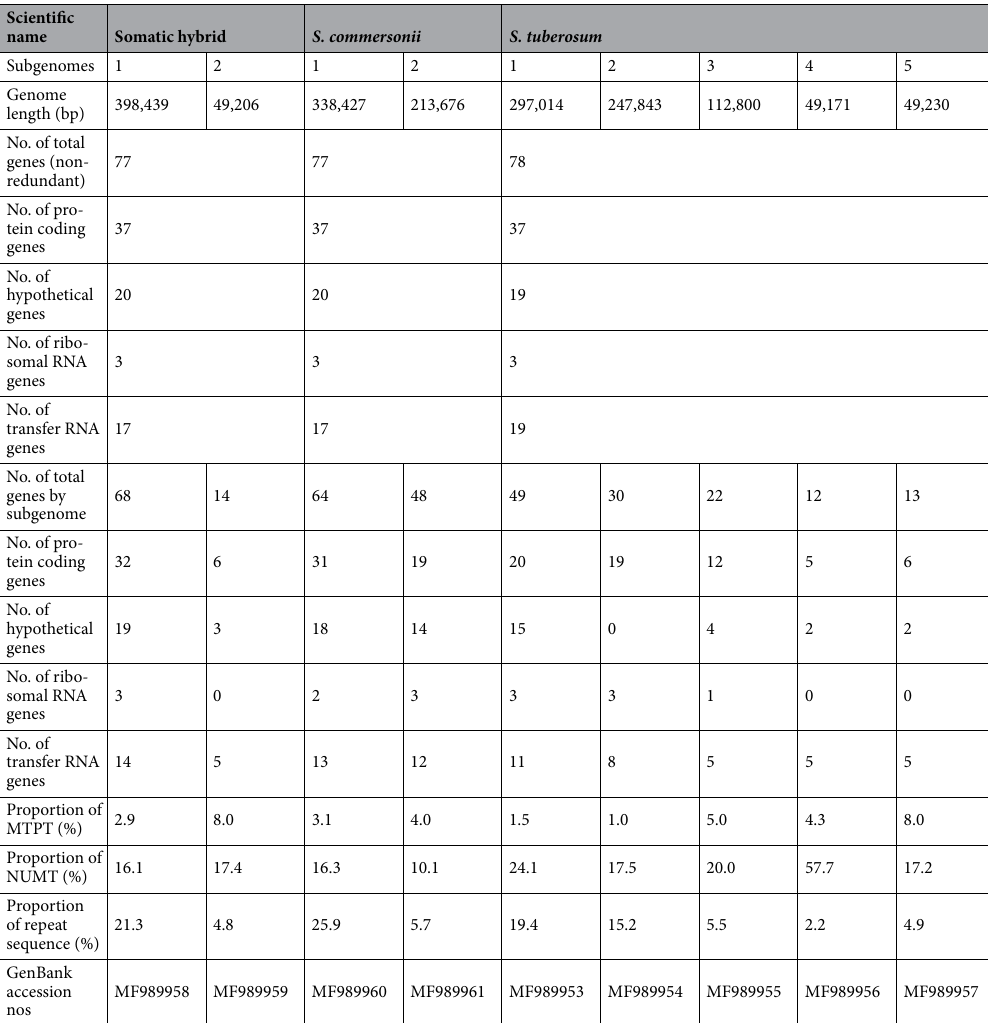
Table 1. Mitogenome features of S. tuberosum, S. commersonii , and their somatic hybrid. MTPT mitochondrial plastid DNA, NUMT nuclear mitochondrial